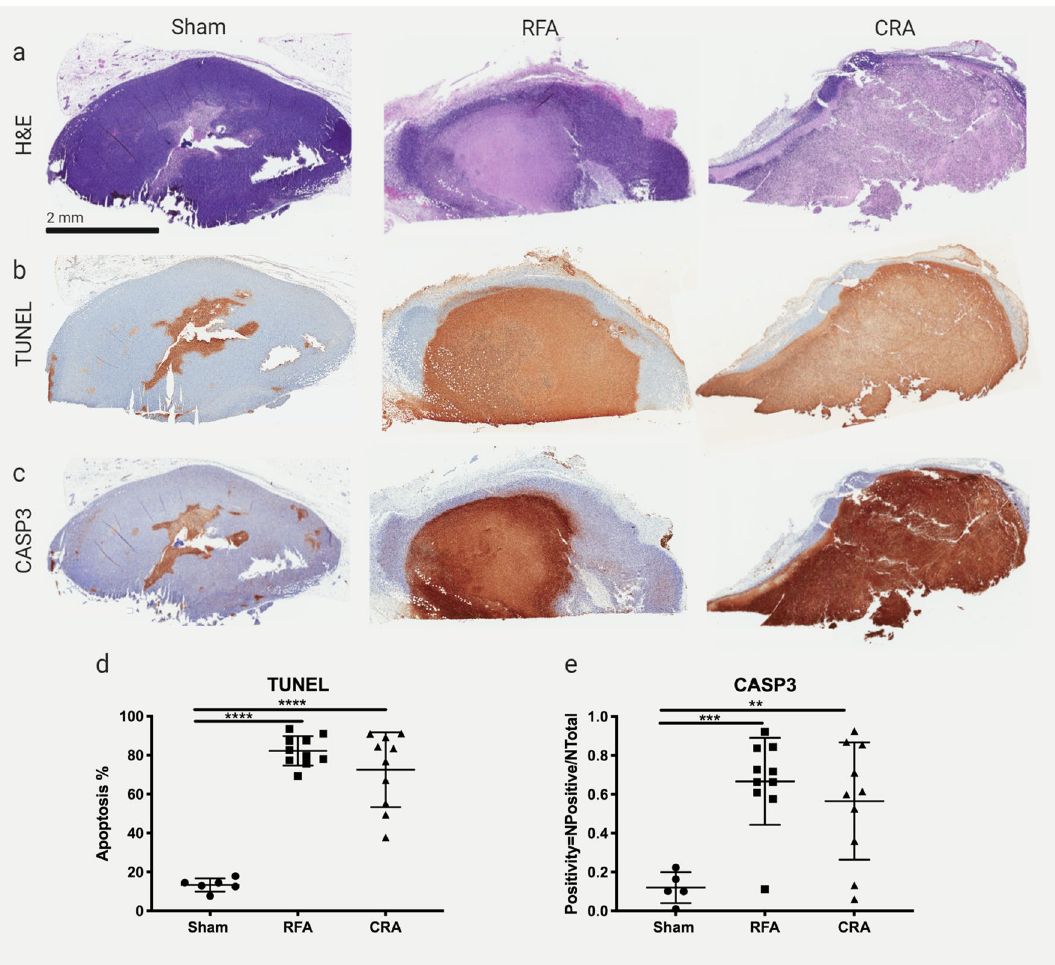
Figure 2. Immunohistochemical analysis of cell death. ( a ) Representative H&E-stained tumor sections from sham, RFA, and CRA treatment groups. ( b ) TUNEL and ( c ) Caspase-3 (CASP3) stains of tumor sections corresponding to the H&E sections. ( d ) TUNEL and ( e ) CASP3 stain quantification. Mean and SD are denoted by large and small bars, respectively. Ordinary one-way ANOVA was performed. **p < 0.01, ****p < 0.0001. Statistical analyses were performed using GraphPad Prism version